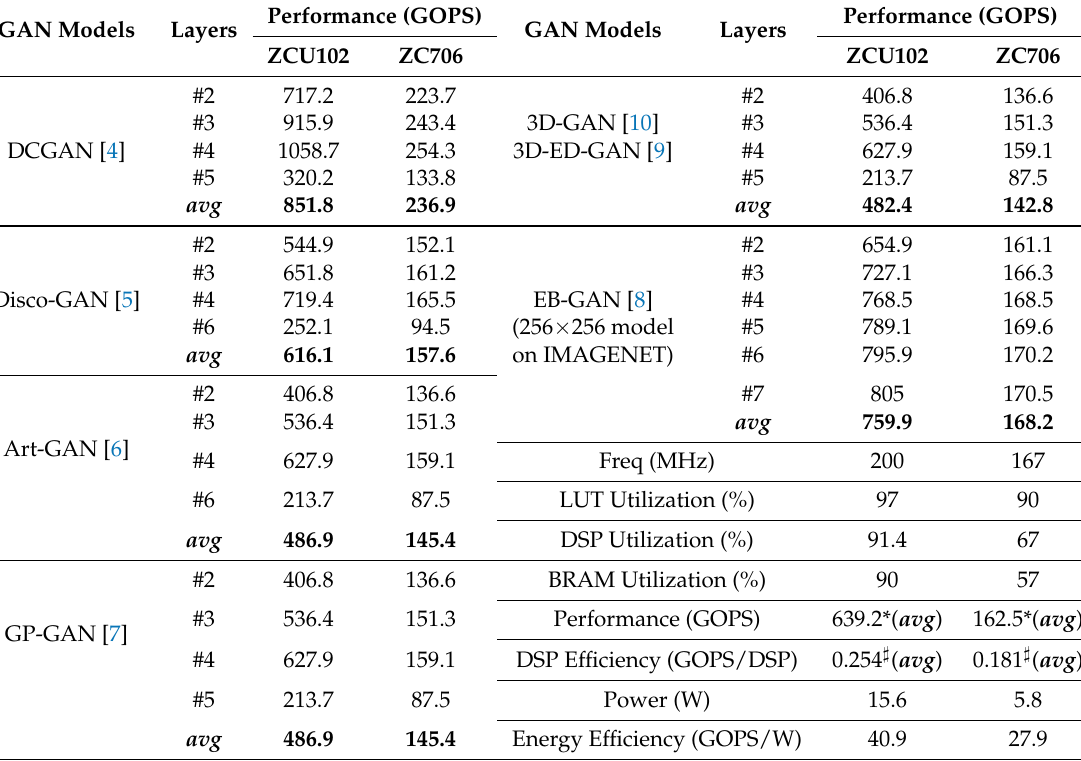
Table 6. Performance and resource report.